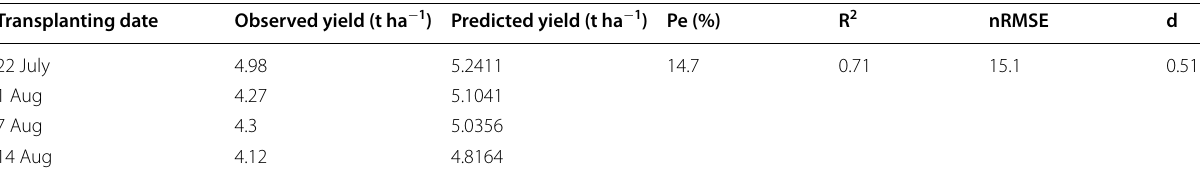
Table 3 Validation of relationship comparing observed and predicted grain yield with irrigation demand at reproductive phase of BR11 during T. Aman, 2016 in Kushtia